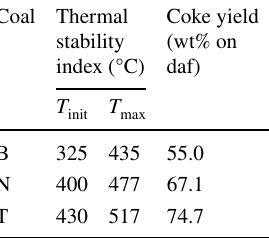
Table 5 The thermal stability indexes of the coals derived from TG–DTG curves